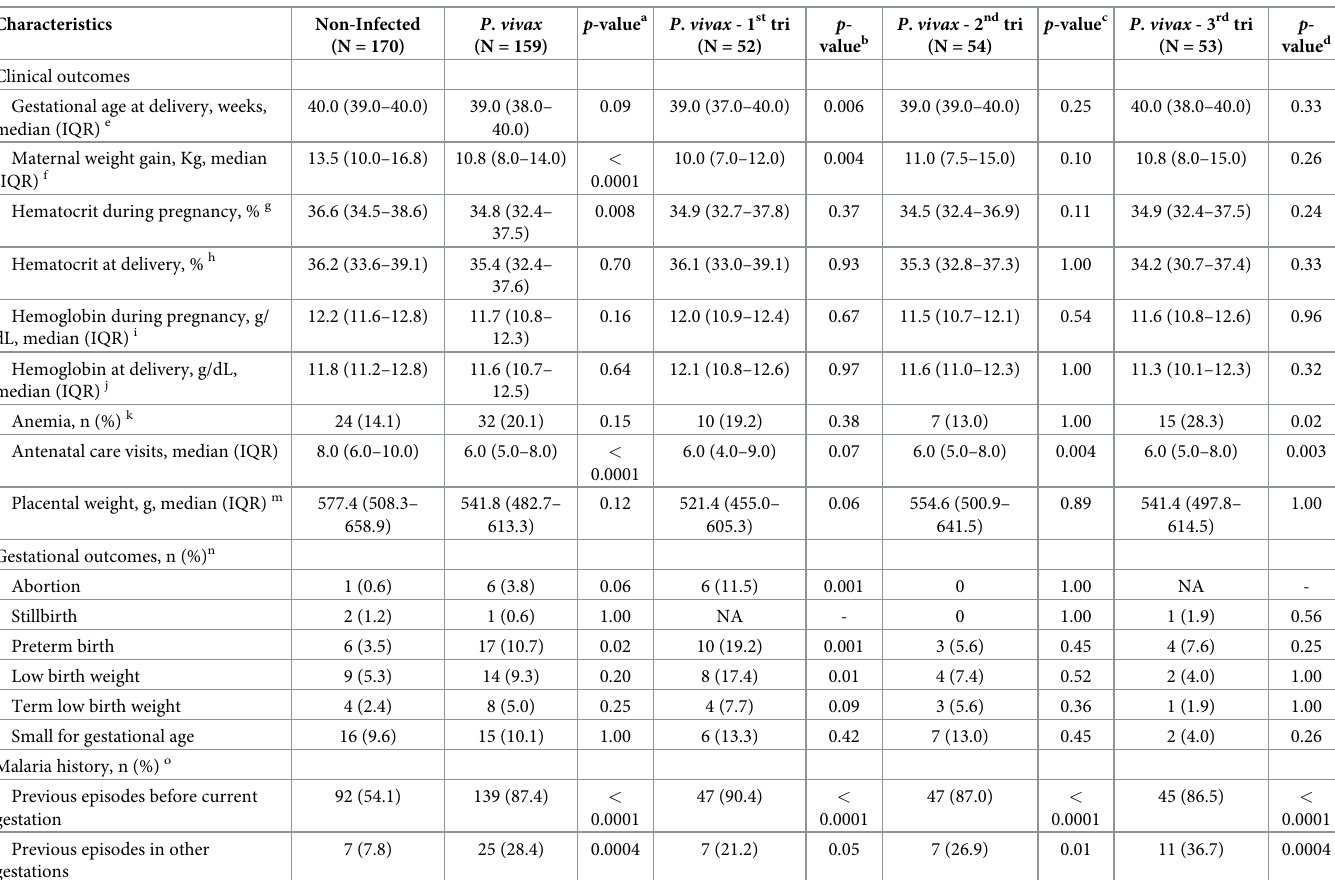
Table 2. Clinical characteristics of the mothers participating in the study, according to infection and gestational trimester of first infection.